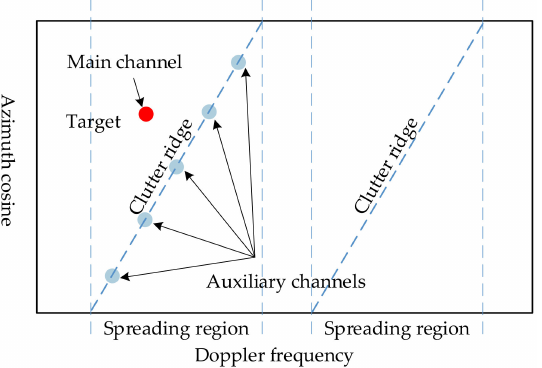
Figure 4. Sketch map of the main channel and auxiliary channels for shipborne high frequency surface wave radar (HFSWR).